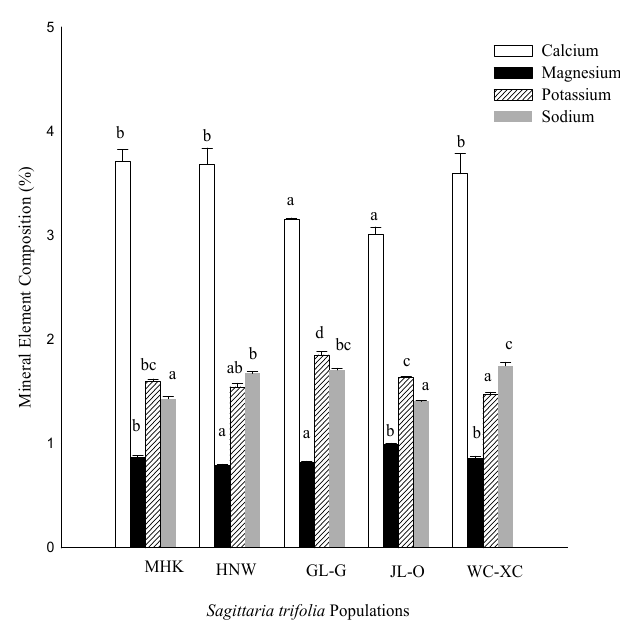
7 of 18 (crude protein), D.M (dry matter/ash), F (Fats); MHK (Meihekou), GL-G (Jilin), JL-O (Siping), HNW (Harbin), WC-XC (Wuchang). 2.6. Mineral Composition (%) The mineral composition was also determined, as indicated in Figure 3, which revealed that all the populations of S. trifolia contained considerable amounts of minerals. However, maximum calcium (Ca) was recorded from MHK followed by HNW, WC-XC and GL-G, respectively, while the minimum mineral elements were recorded by JL-O. Maximum magnesium (Mg) was observed in JL-O followed by MHK and WC-XC and GL-G, respectively. The lowest magnesium content was reported to be 0.79% from HNW. Moreover, the potassium content (K) is slightly greater with highest percentage in GL-G followed by JL-O, MHK, HNW and WC-XC, respectively. Maximum sodium (Na) was recorded by WC-XC followed by GL-G and HNW. However, minimum (Na) was